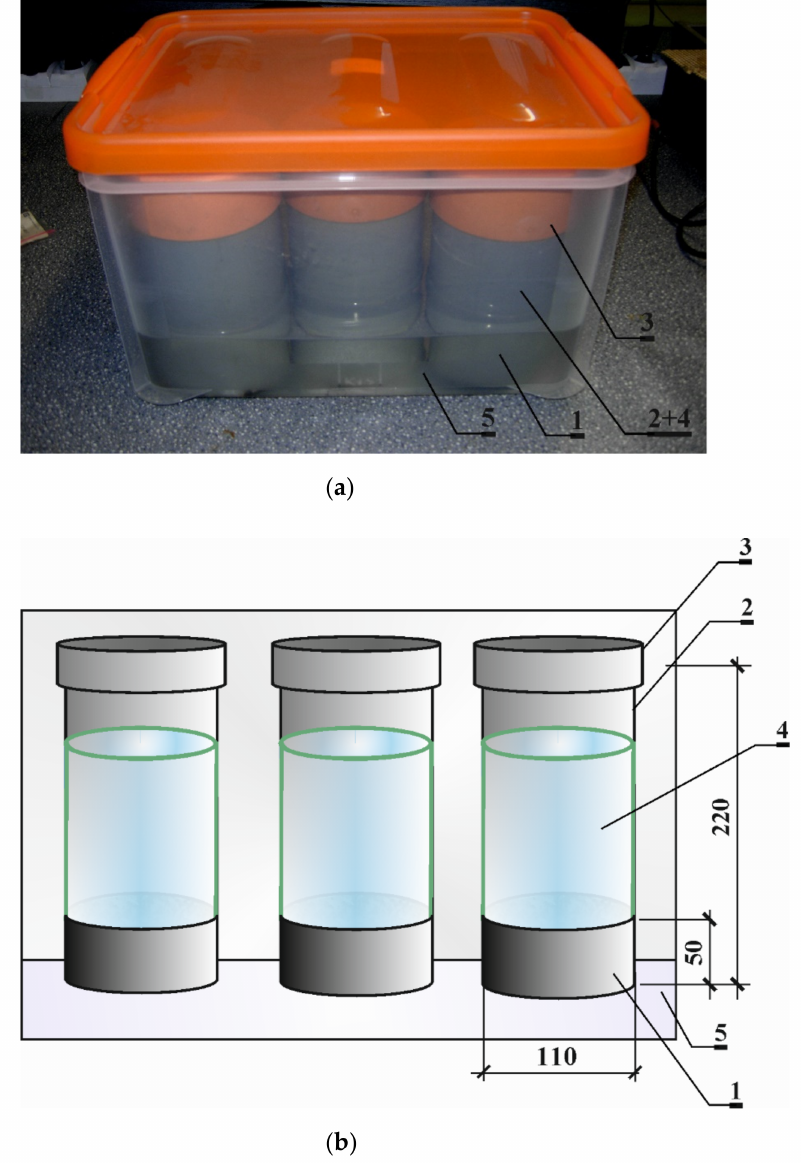
Figure 1. View of the diffusion test stand ( a ) and its diagram ( b ): 1—concrete sample, 2—container for 3% NaCl solution, 3—conventional plugs in order to eliminate evaporation of water from the container of the solution, 4—3% NaCl solution, 5—distilled water. Dimensions in